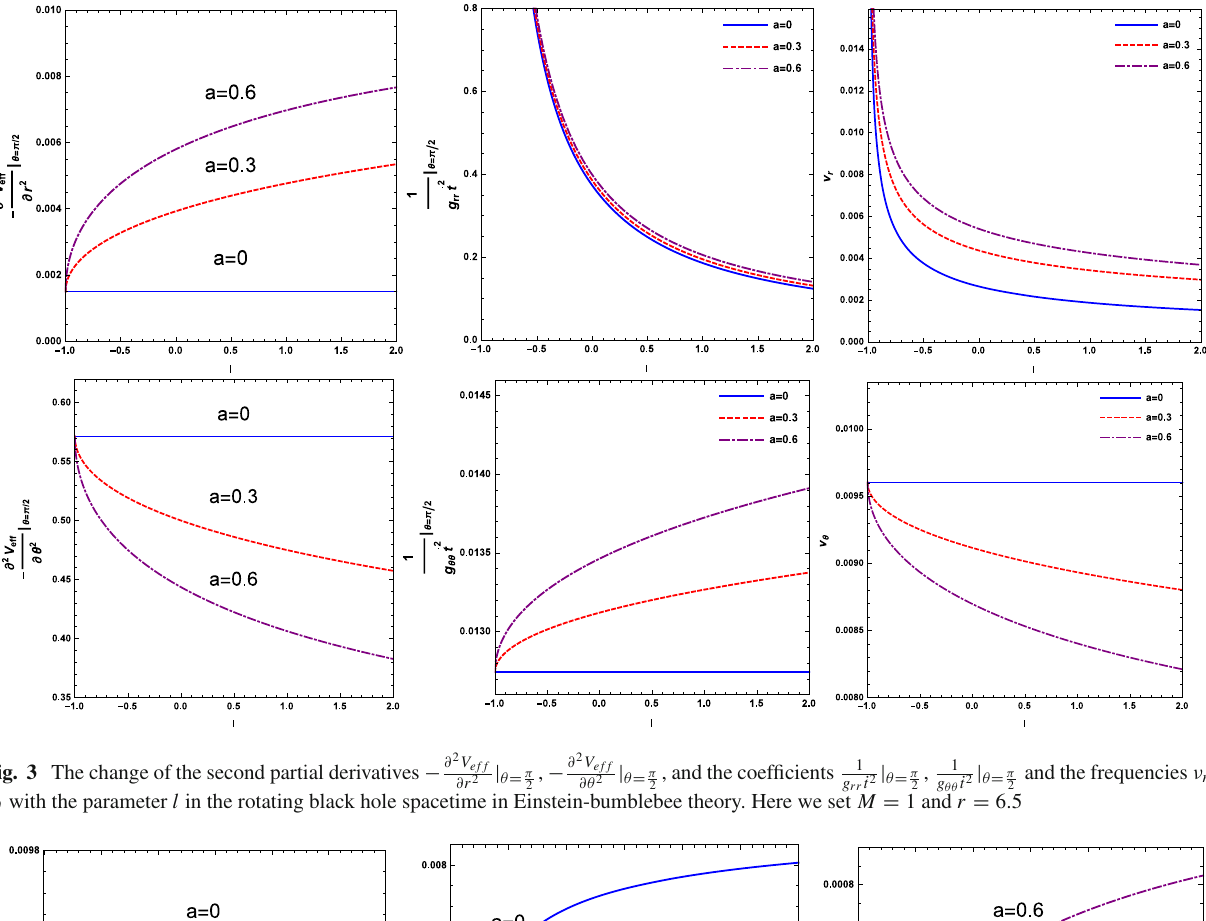
| θ = π | θ = π , 1 and the frequencies ν r , g rr ˙ t 2 g θθ ˙ t 2 2 2